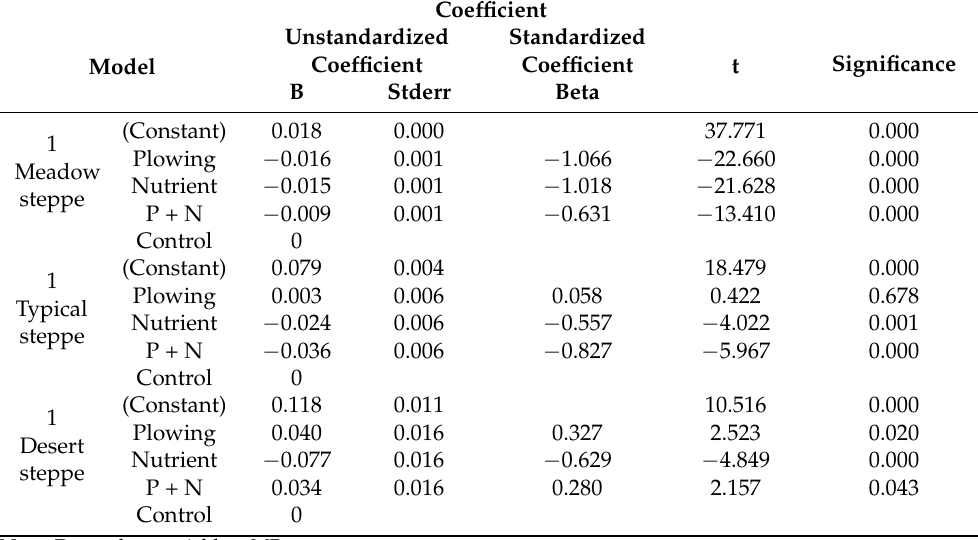
Table 3. Linear regression analysis of soil microbial entropy.